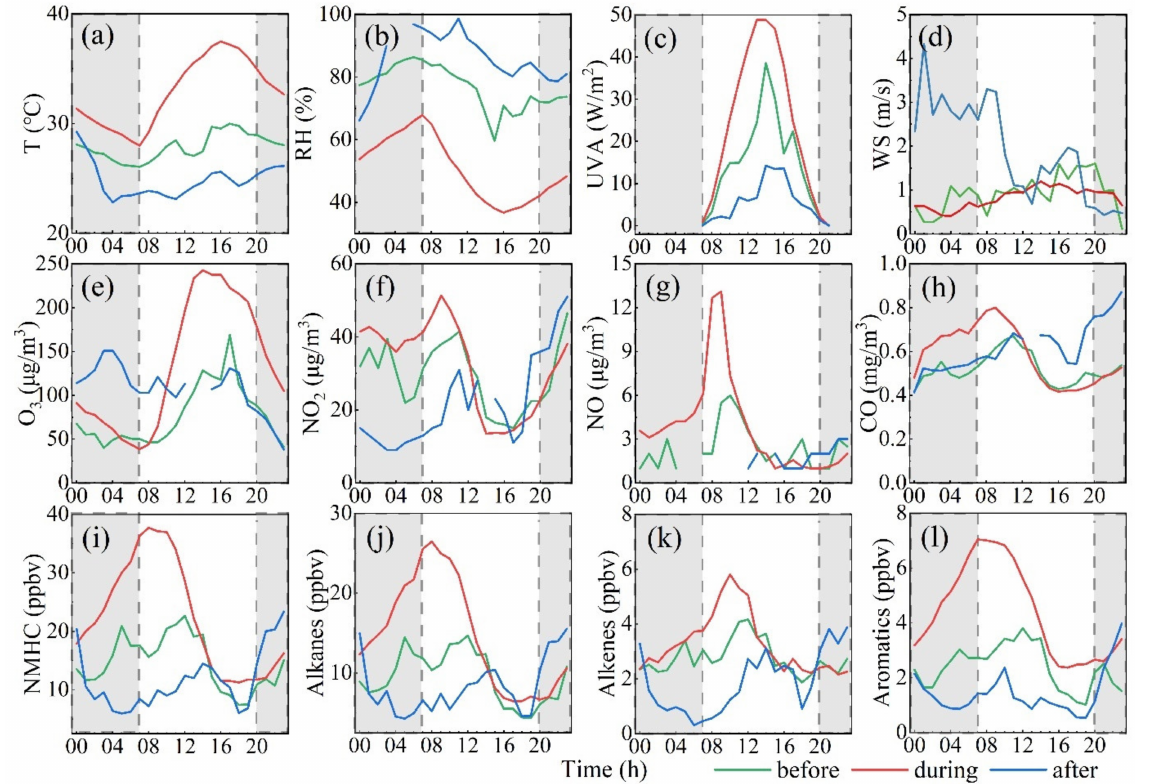
Figure 3. Diurnal and nocturnal variation of meteorological parameters ( a – d ), gaseous pollutants ( e – h ), and NMHCs ( i – l ) before (25 July–26 July), during (27 July–4 August), and after (5 August) the O 3 pollution. The gray shaded area indicates nighttime (daytime: 7:00–20:00 CNST; nighttime: 21:00–6:00